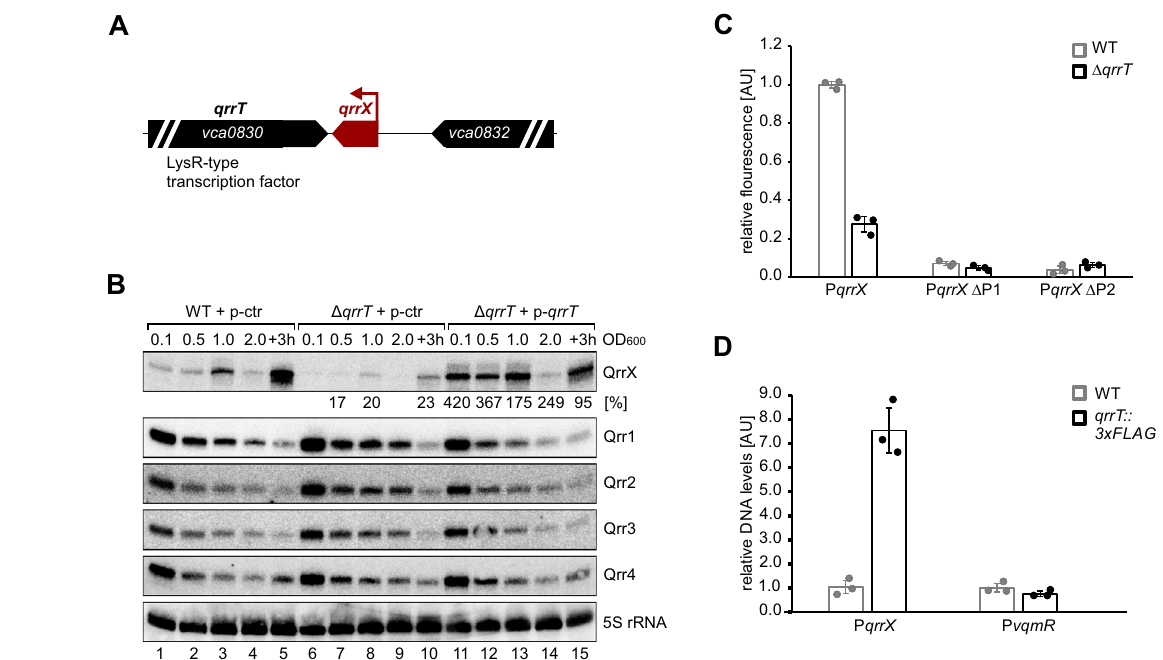
Fig. 5 | Transcriptional control of qrrX . A Schematic representation of the genomic context of qrrX . The qrrX gene is marked in red. The vca0830 gene encodes a LysR-type transcription factor (QrrT). B Role of QrrT for QrrX levels. V. cholerae wild-type and Δ qrrT cells harboring either an empty control vector or a qrrT overexpression plasmid (p- qrrT ) were cultivated in LB medium and RNA samples were collected at different stages of growth. Northern blot analysis was performed to determine QrrX and Qrr1-4 levels. 5S ribosomal RNA served as loadingcontrol.The experimentwasperformed withthree independent biological replicates ( n =3). C Regulation of the qrrX promotor. V. cholerae wild-type and Δ qrrT cells carrying an mKate2-based transcriptional reporter for qrrX